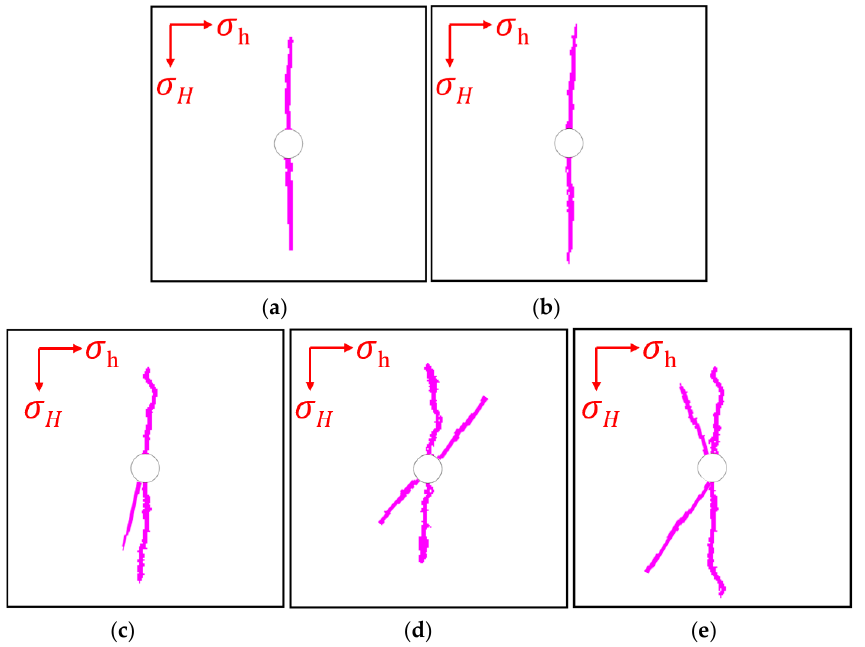
Figure 8. Numerical simulation results when injecting various fluids. ( a ) Viscous oil; ( b ) water; ( c ) liquid carbon dioxide; ( d ) supercritical carbon dioxide; ( e )